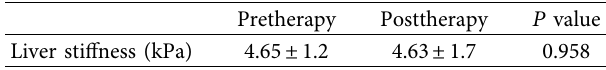
Table 3: Magnetic resonance elastography